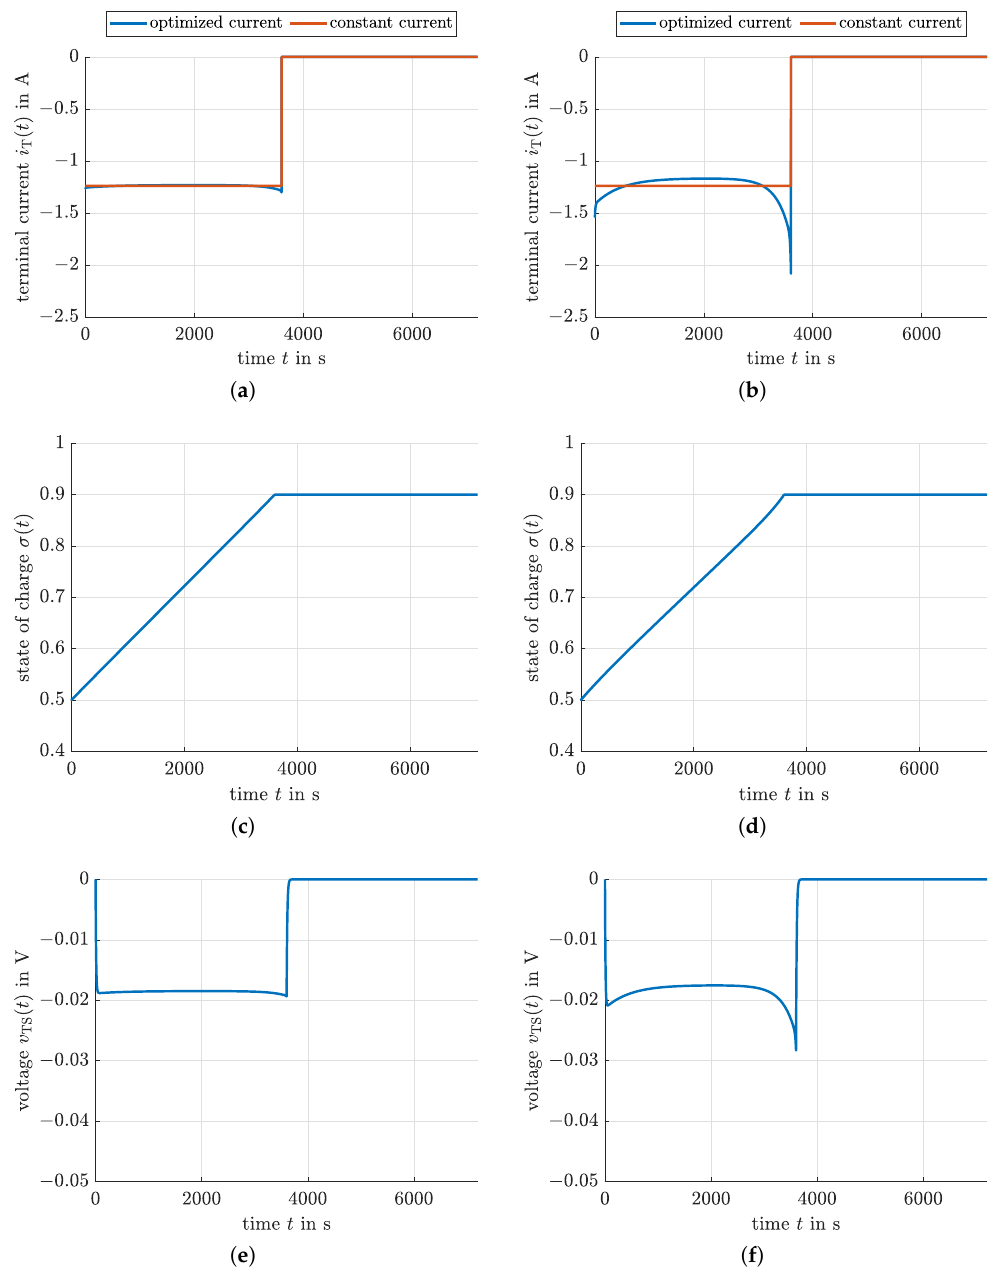
Figure 5. Offline optimization of the charging profile according to Section 3.1.2. ( a ) Terminal current i T ( t ) for α = 1; ( b ) Terminal current i T ( t ) for α = 0.01; ( c ) SOC σ ( t ) for α = 1; ( d ) SOC σ ( t ) for α = 0.01; ( e ) Voltage v TS ( t ) for α = 1; ( f ) Voltage v TS ( t ) for α =